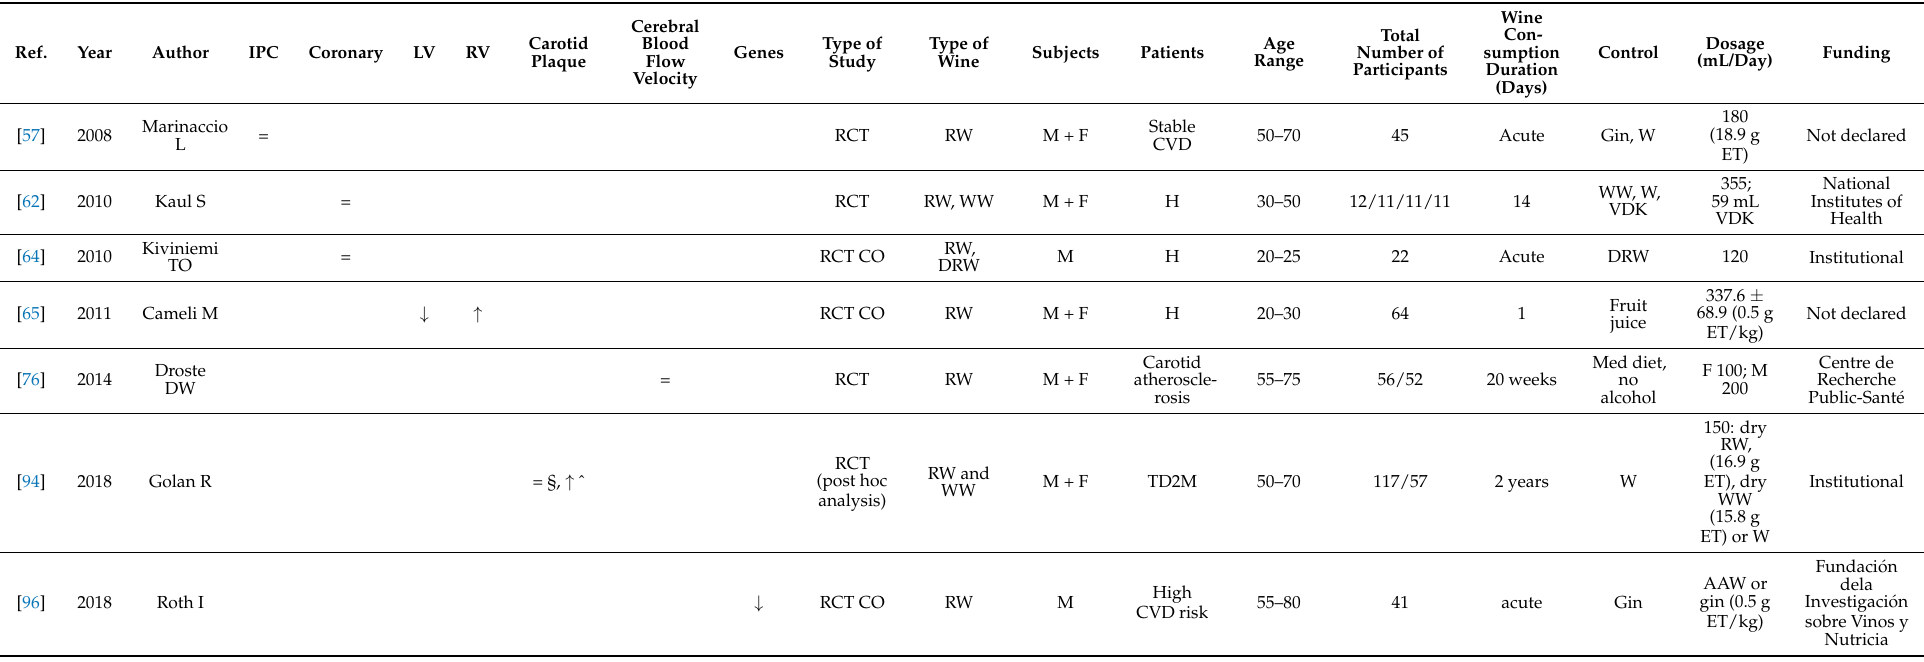
Table 2. Overview of studies that evaluated the cardiovascular effects of red wine